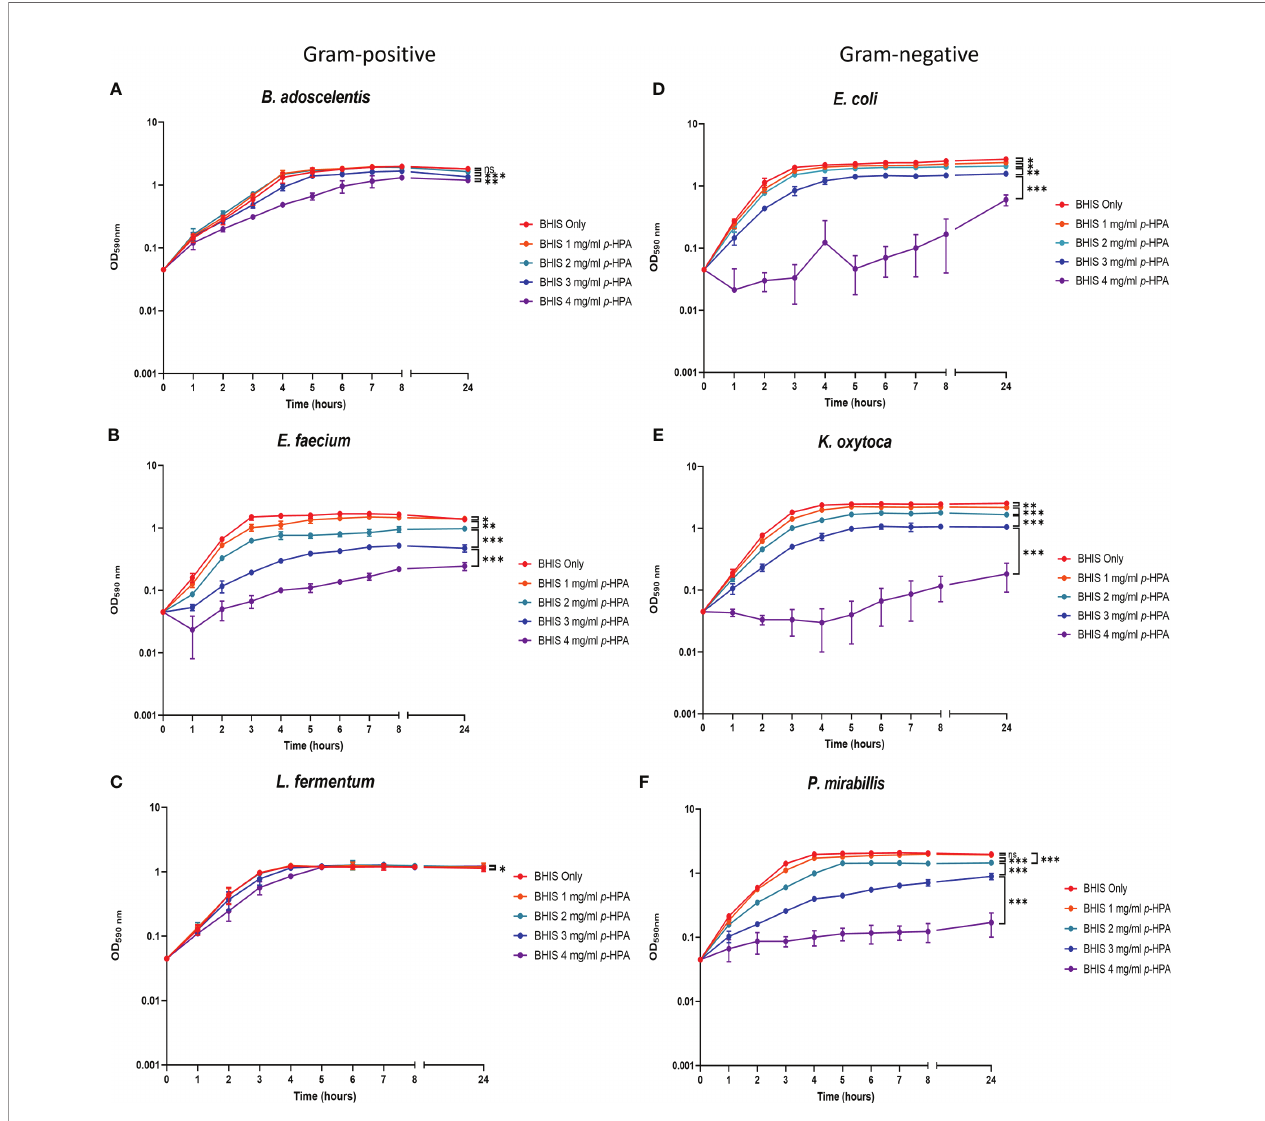
FIGURE 6 | Analysis of the growth of C. dif fi cile and gut commensal species in the presence of p -HPA. Six representative gut commensal species,three Gram- positive: (A) Bi fi dobacterium adoscelentis , (B) Enterococcus faecium , (C) Lactobacillus fermentum , and three Gram-negative; (D) Eschericia coli , (E) Klebsiella oxytoca , (F) Proteus mirabilis strains were grown in BHIS media with 0, 1, 2, 3, and 4 mg/ml p -HPA. Growth curves represent three biological replicates. ANOVA was used to determine signi fi cant differences between growth curves. Error bars represent standard deviation, and signi fi cant differences are indicated: * p < 0.05, ** p < 0.01, *** p < 0.001, ns, non signi fi cant